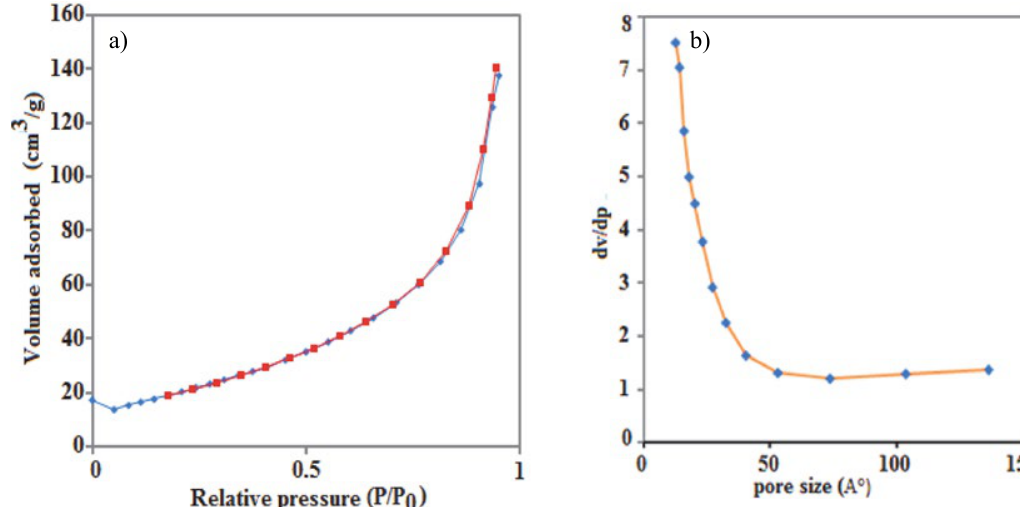
O /GrO-NH /H PMo O at different time intervals: (a) MB dye, (b) RhB dye, 3 4 2 3 12 40